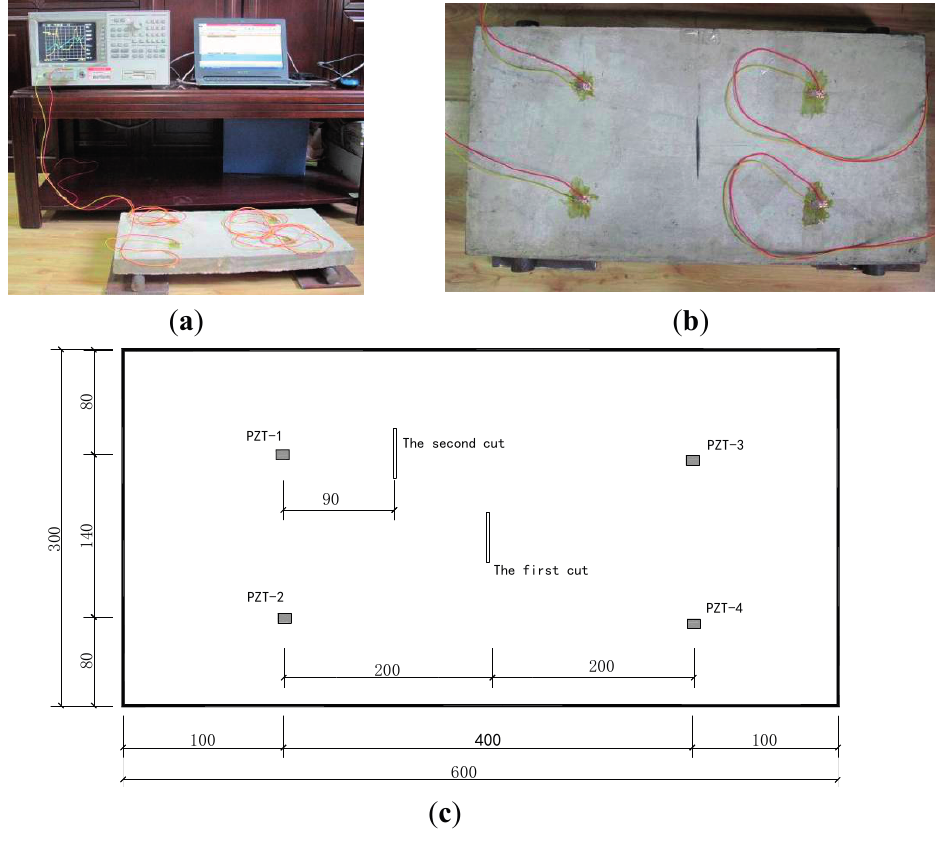
Figure 3. ( a )Test equipment ( b ) First track of damage in reinforced concrete slab; ( c ) Plan of concrete